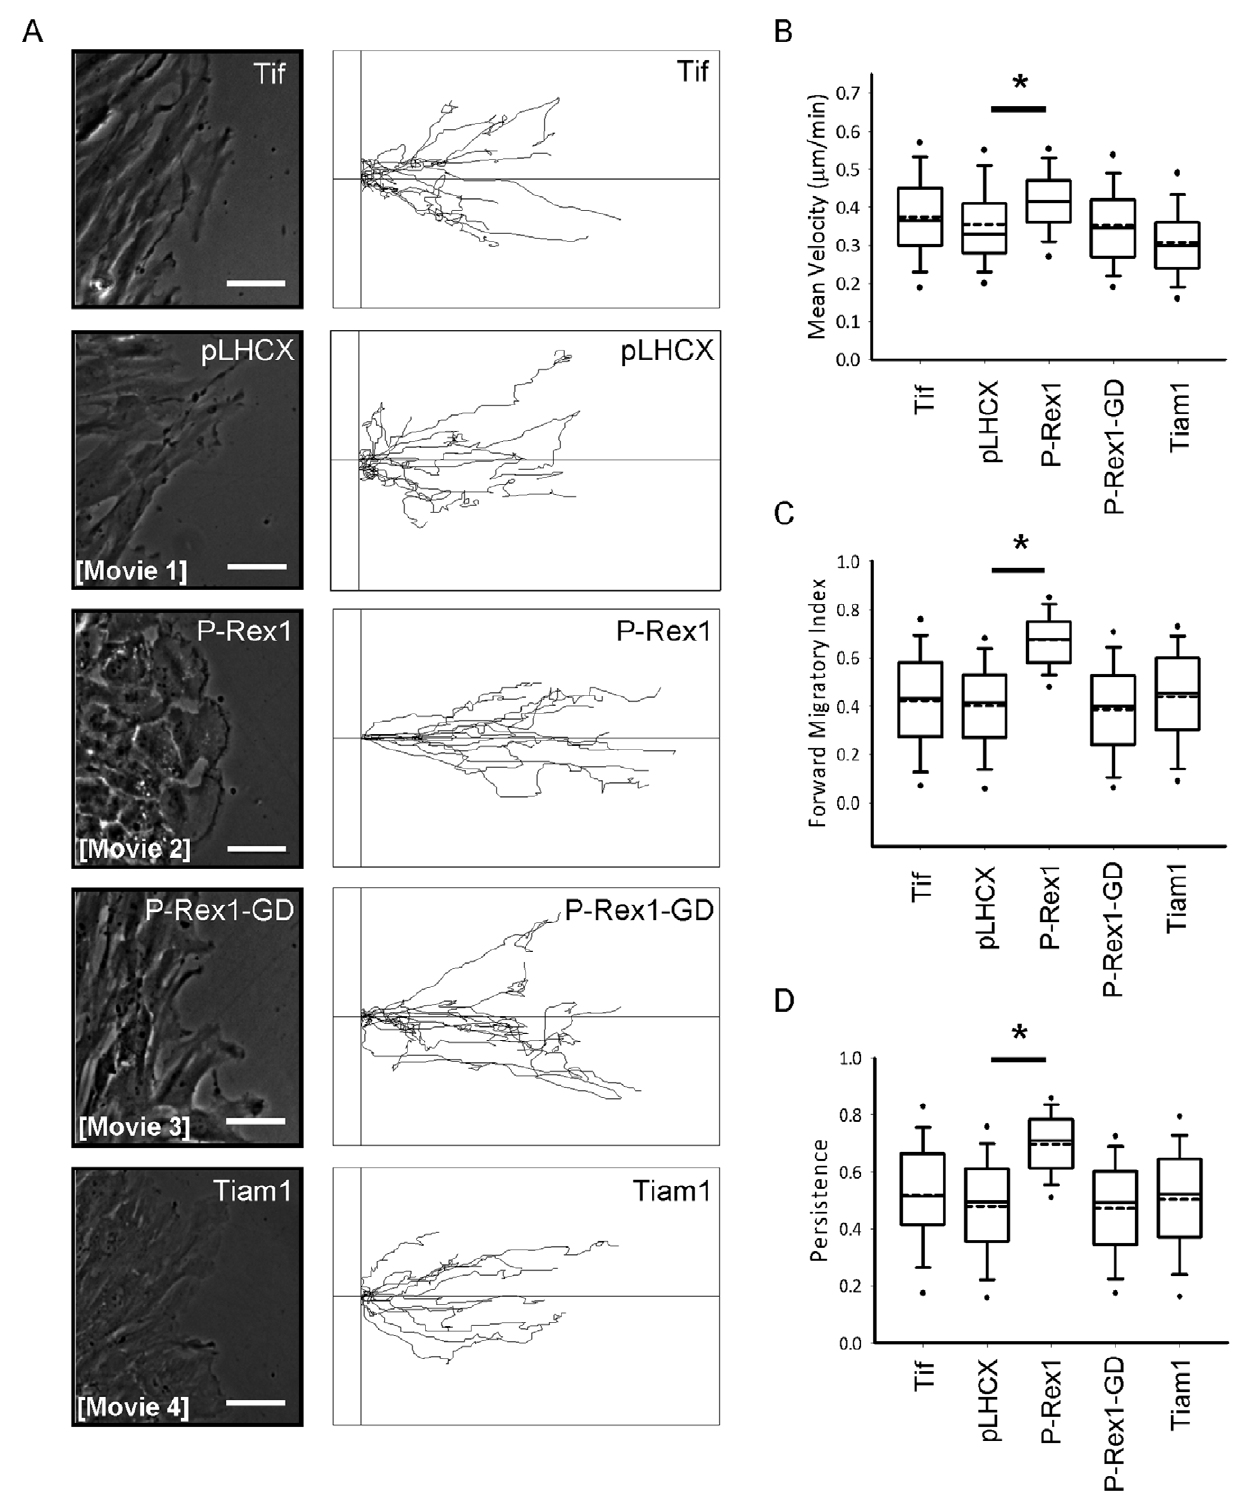
Figure 2. P-Rex1 expression promotes persistent migration on a 2D substrate. (A) Parental (Tif), and control vector (pLHCX) or RacGEF expressing fibroblasts emerging from the migratory front of scratch-wound assays were analysed using time-lapse microscopy, with images captured every 10 minutes over a period of 18 hours. Individual cells were manually tracked and the migratory path of representative cells depicted as track plots. The phase contrast images correspond to the initial frame from the supplementary movies S1–S4 as indicated. (B-D) Influence of RacGEF expression on migratory behaviour was quantified by determination of mean cellular velocity (B), forward migratory index (C) and migratory persistence (D). (Bars 50 m m, ** P , 0.005, Mann-Whitney rank sum test).